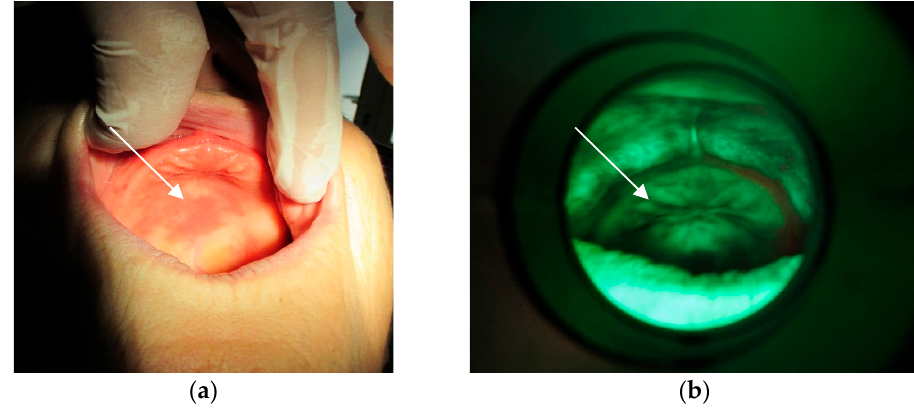
Figure 8. ( a ) Mucosa with lesions. ( b ) Fungal colonies over the mucosa.